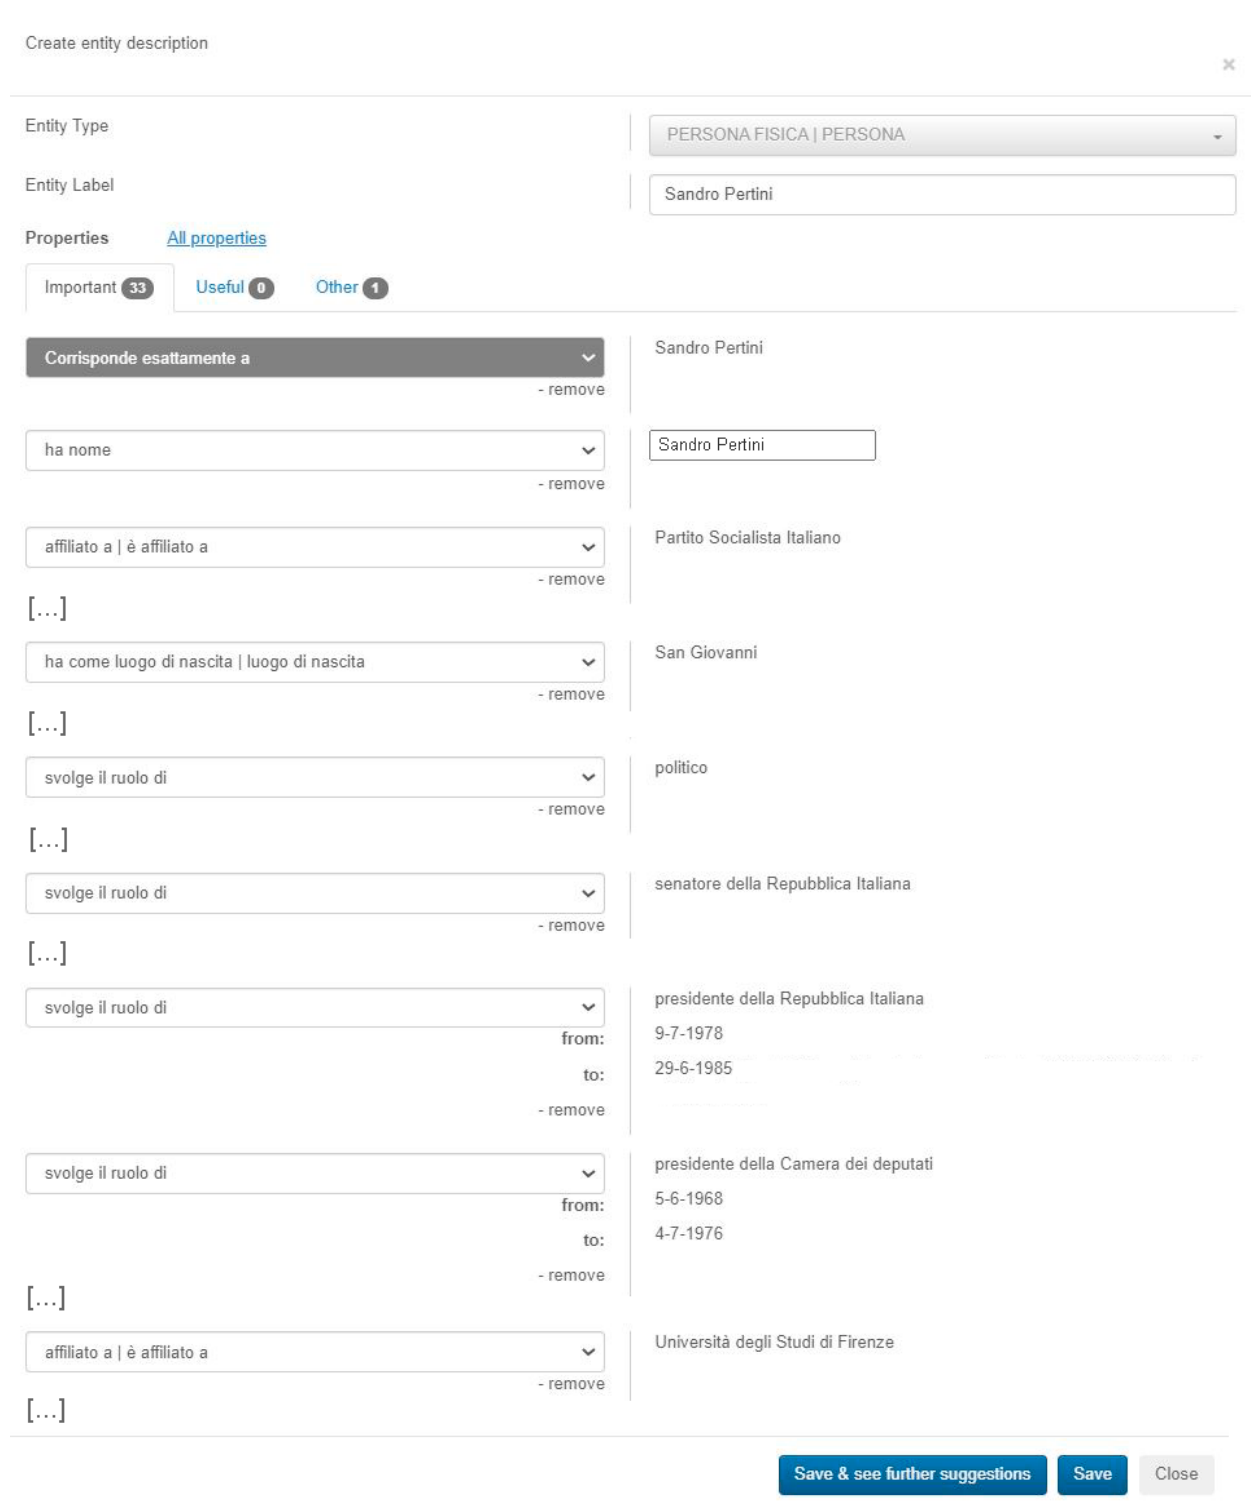
Figure 12. The form to characterize Sandro Pertini, filled in with suggestions obtained from Wikidata.